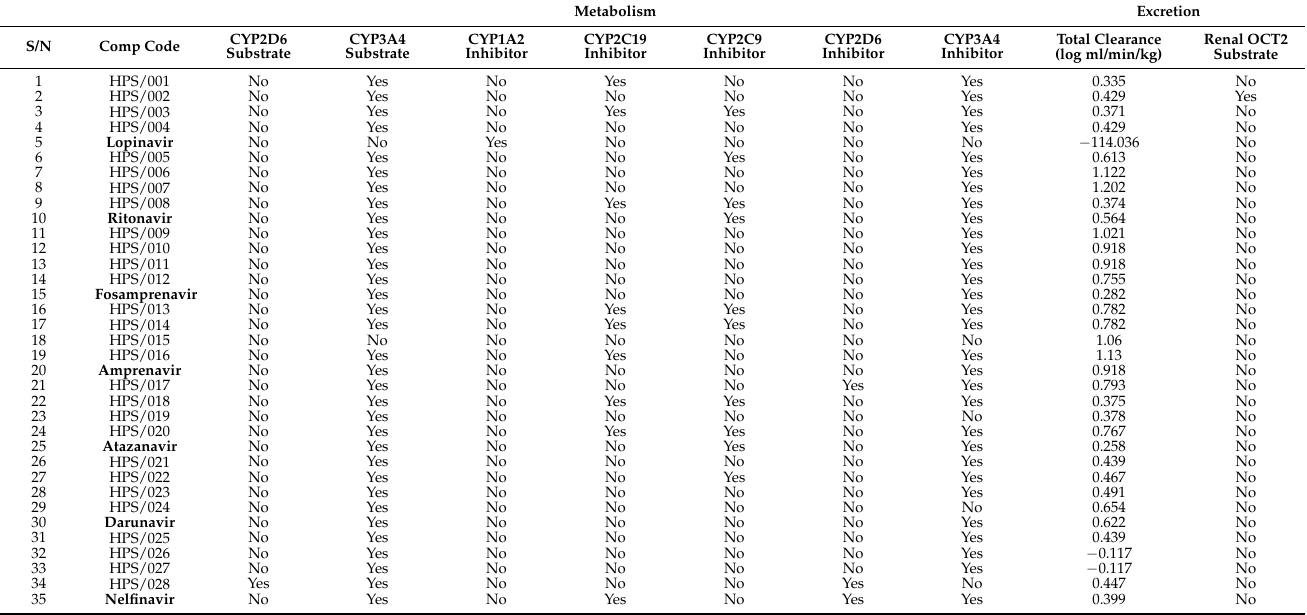
Table 5. Metabolism and excretion